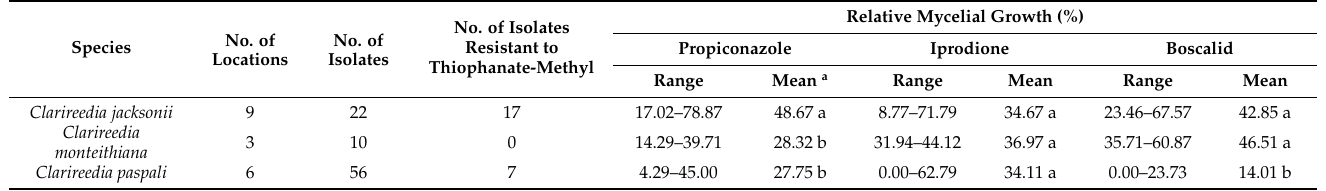
Table 2. Sensitivity profiles of the three Clarireedia species to thiophanate-methyl, propiconazole, iprodione, and boscalid.